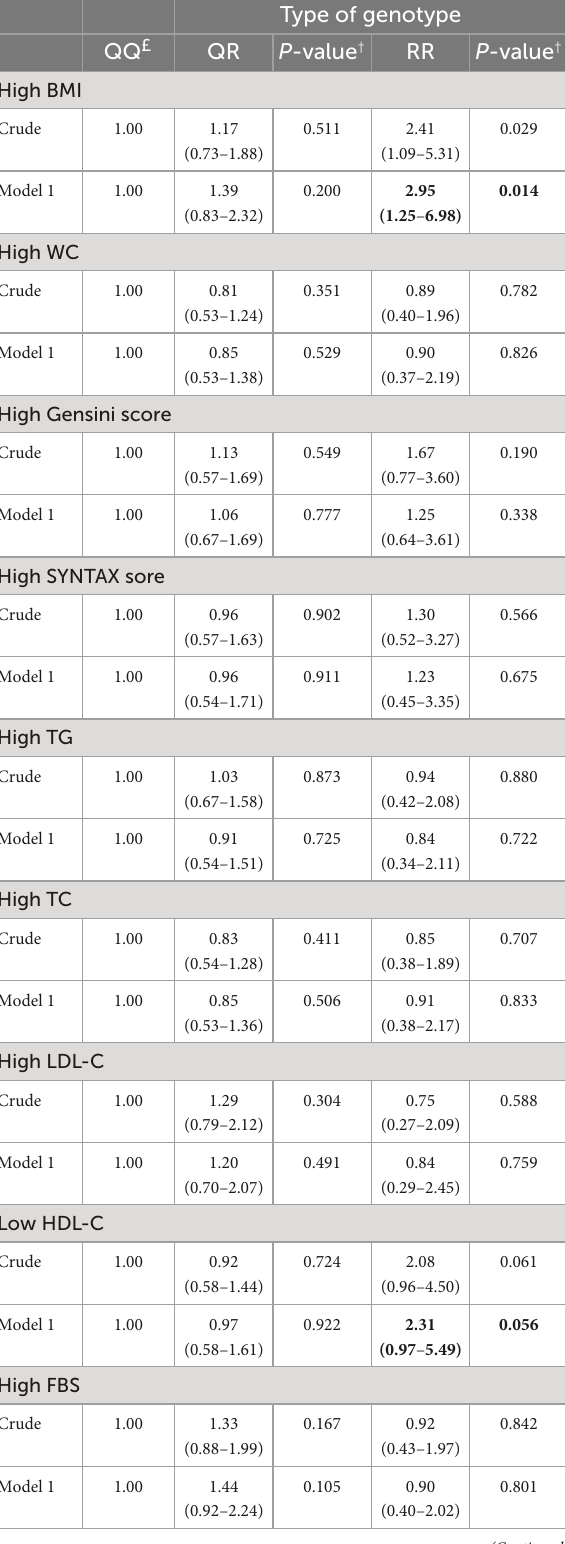
TABLE 2 Anthropometric indices, biochemical parameters, and other CAD risk factors across PON1 gene variants. Variables